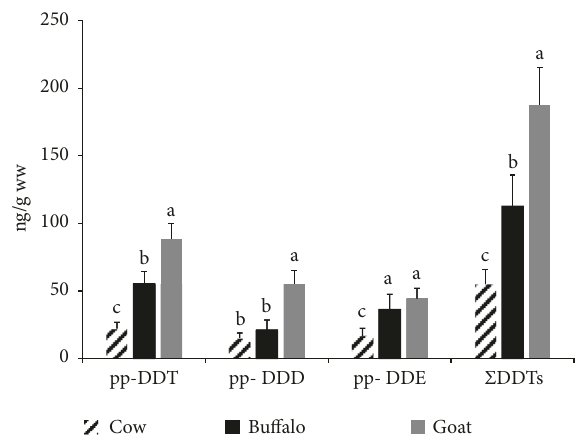
Figure 3: Total DDT and its metabolites in the examined milk samples. Data represent mean ± SE (ng/g ww) for total DDT and its metabolites in the examined milk samples from different animal species (n=20 each). Columns that carry different superscript letter among the same chemical are significantly different at p < 0.05.